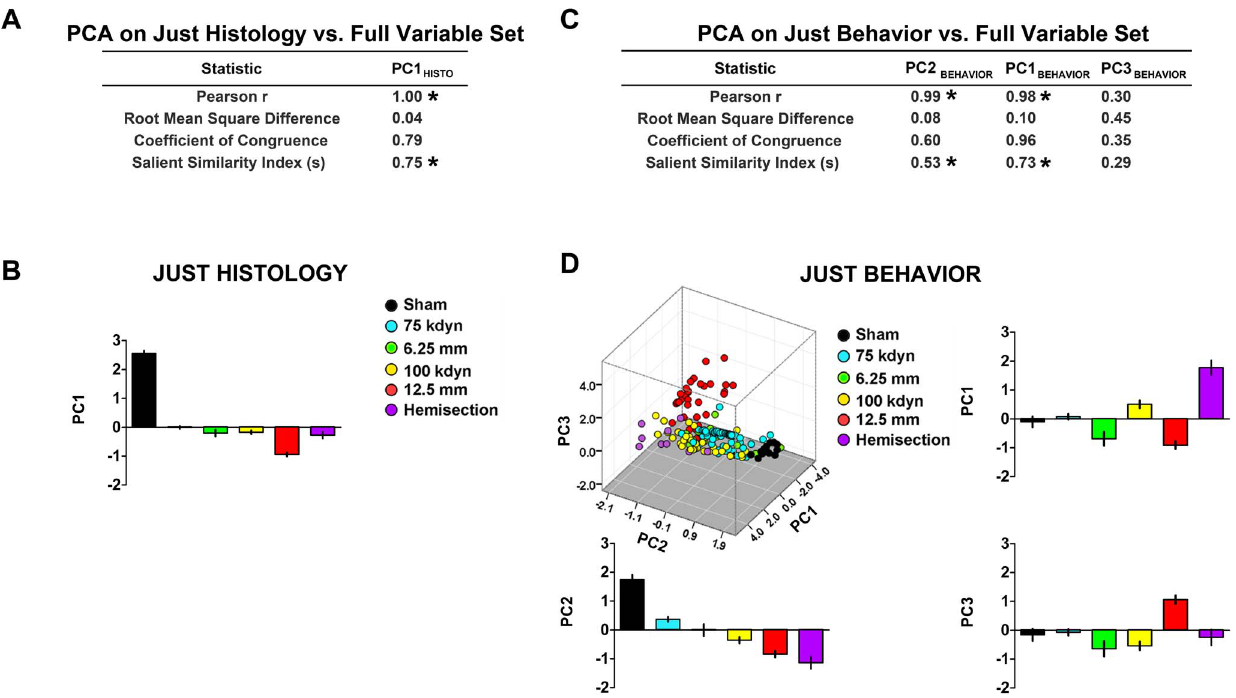
Figure 5. Consistency of PCA across subsets of variables. A, Independent PCA extraction using only histological variables demonstrated significant replication of PC1 extracted using the full variable set. B, Injury condition affected PC1 HISTO in an equivalent manner to the full-variable extraction (compare to Figure 4E). C, PCA extraction using only behavioral variables significantly replicated the full variable PC for PC1 and PC2, however the sequence of extraction reversed, indicating a reversal in variance explained by PC1 BEHAVIOR and PC2 BEHAVIOR . D, Scores of individual subjects on PC1-3 extracted from just-behavioral variables. The pattern for PC2 BEHAVIOR recapitulated PC1 from the full variable extraction (compare to Fig. 4E) and PC1 BEHAVIOR recapitulated PC2 from the full-variable extraction (compare to Fig. 4F). * P , .05 for replication statistics, s .